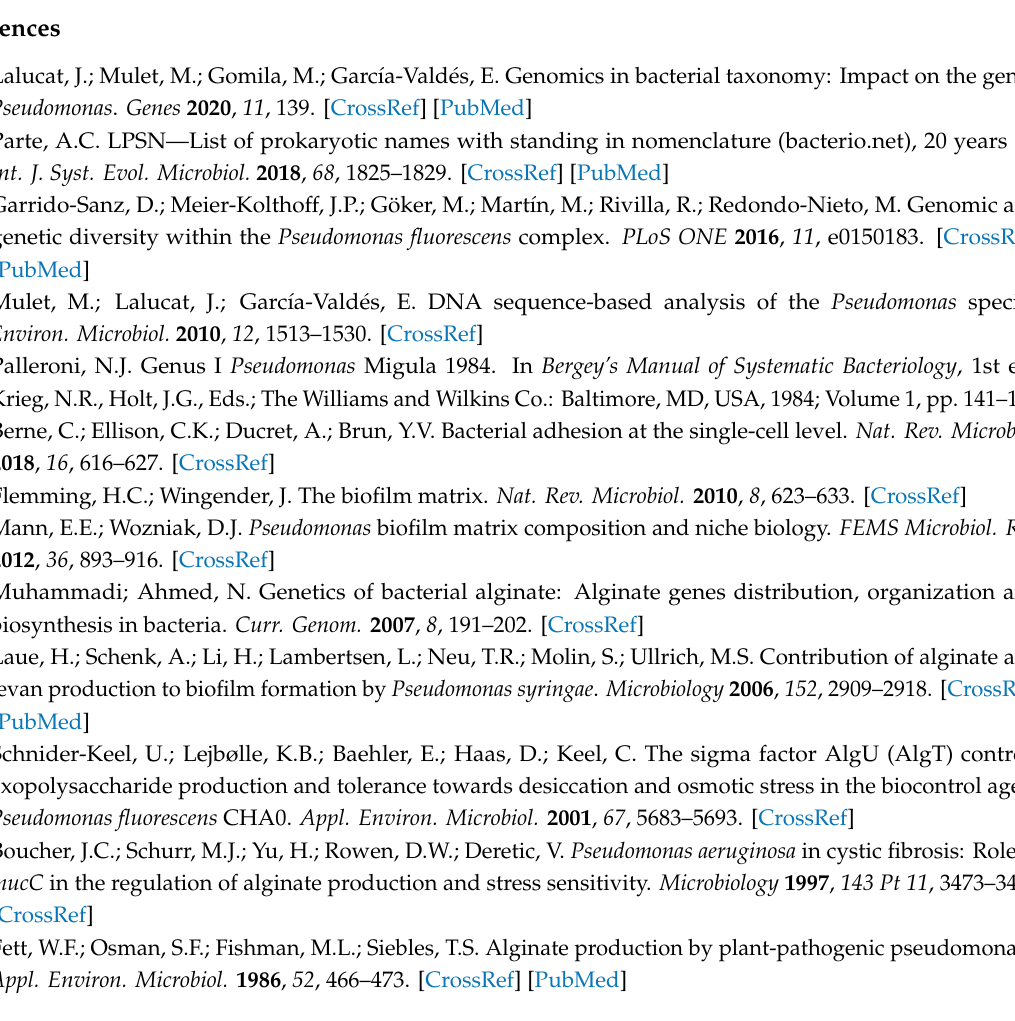
Figure S1: Domain analysis of Pseudomonas fluorescens F113 extracellular proteins MapA and PsmE; Figure S2: Maximum-likelihood phylogenetic tree of the 611 Pseudomonas based on 149 single-copy amino acid sequences; Table S1: Comparison of Pseudomonas fluorescens F113 ECM components outside Pseudomonadales ; Table S2: List of Pseudomonas genomes used in this study; Table S3: Nucleotide and amino acid sequences comparison of Pseudomonas fluorescens F113 gene clusters inside the genus Pseudomonas ; Table S4: Predicted localization, domains, and function of Pseudomonas acidic polysaccharide (Pap) biosynthetic proteins in Pseudomonas fluorescens F113; Table S5: Percentage of Pseudomonas genomes containing an ortholog of extracellular matrix components; Table S6: Pseudomonads containing the fimbrial low-molecular-weight protein ( flp ) / tight adherence ( tad ) and / or Pseudomonas acidic polysaccharide ( pap ) biosynthetic